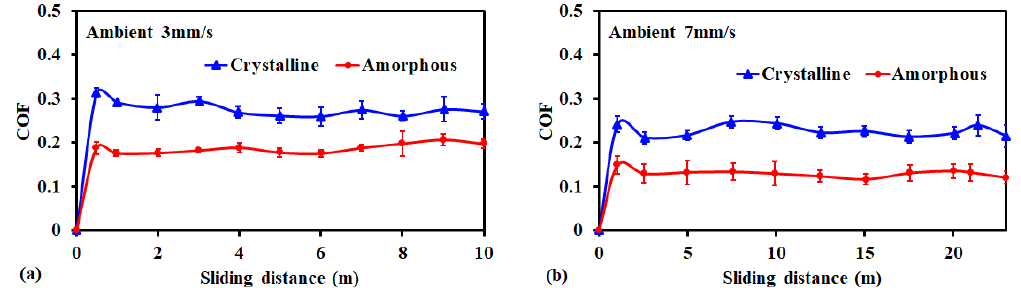
Figure 5. The measured coefficient of friction (COF) for crystalline Pd and amorphous Pd alloy samples with respect to sliding distance with the ionic liquid at room temperature: ( a ) Sliding speed of 3 mm/s, ( b ) sliding speed of 7 mm/s. Table 2. Summary of steady-state COF values for each test configuration.